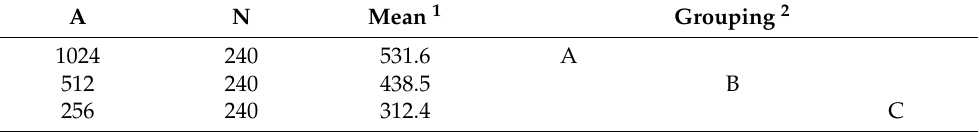
Table 5. Tukey post-hoc analysis for A and MT . MT was positively related to A .